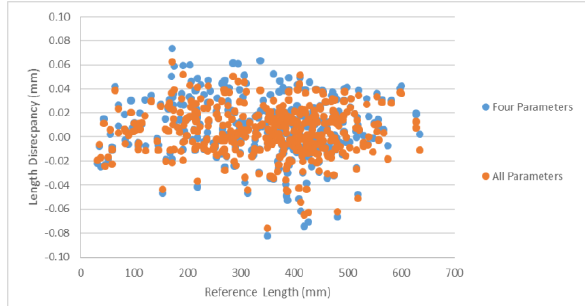
Figure 15 Length discrepancies computed between reference and estimated 3D target coordinates on the Manhattan